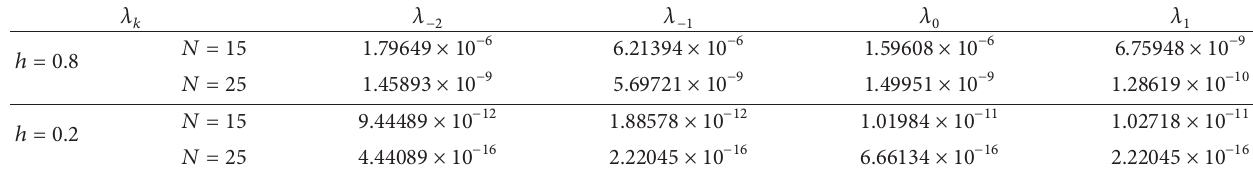
Table 5: Absolute error |𝜆 𝑘 − 𝜆 𝑘,𝑁 | .